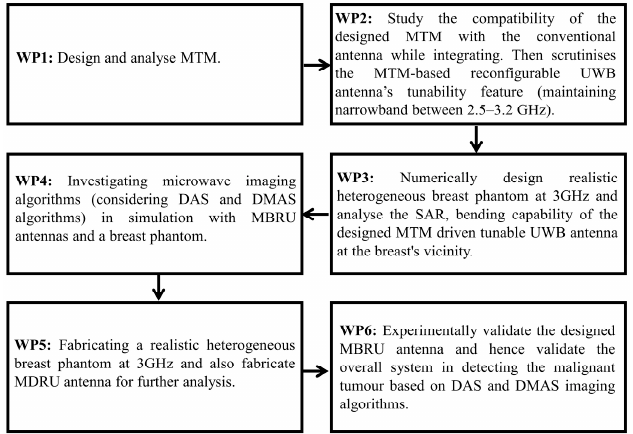
Figure 1. Block diagram of research phases in this study.